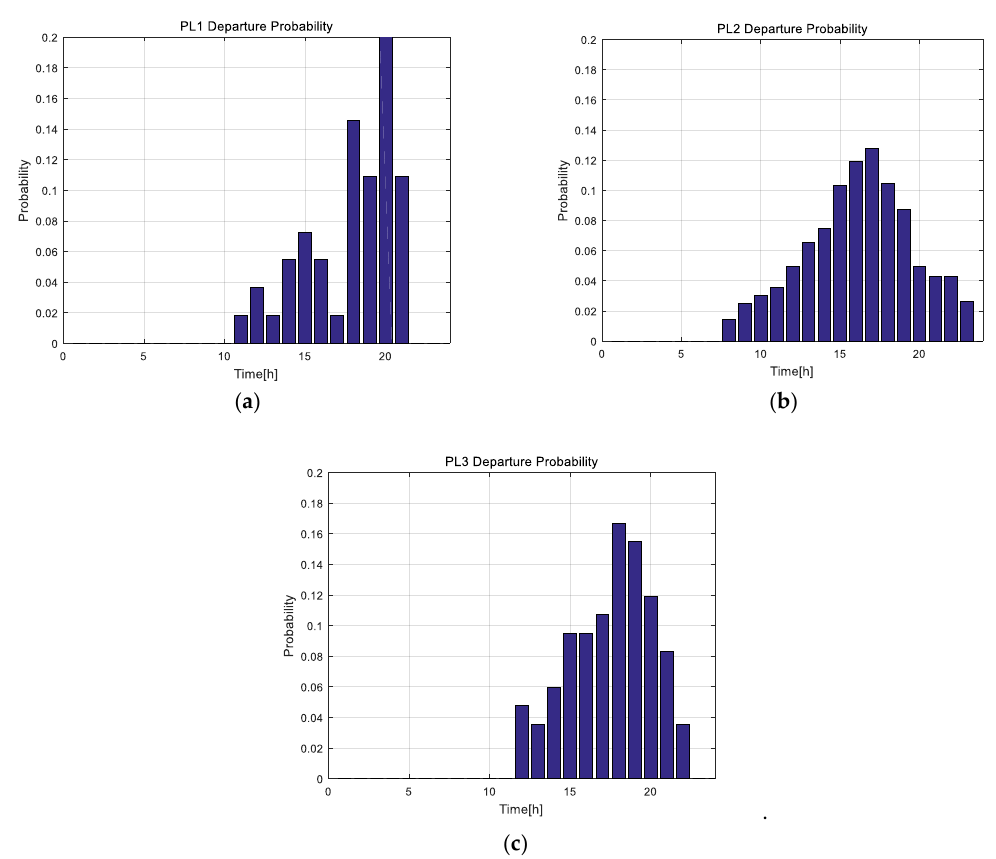
Figure 8. The Probability of Departure from the Parking Lot ( a ) PL1, ( b ) PL2, ( c ) PL3.